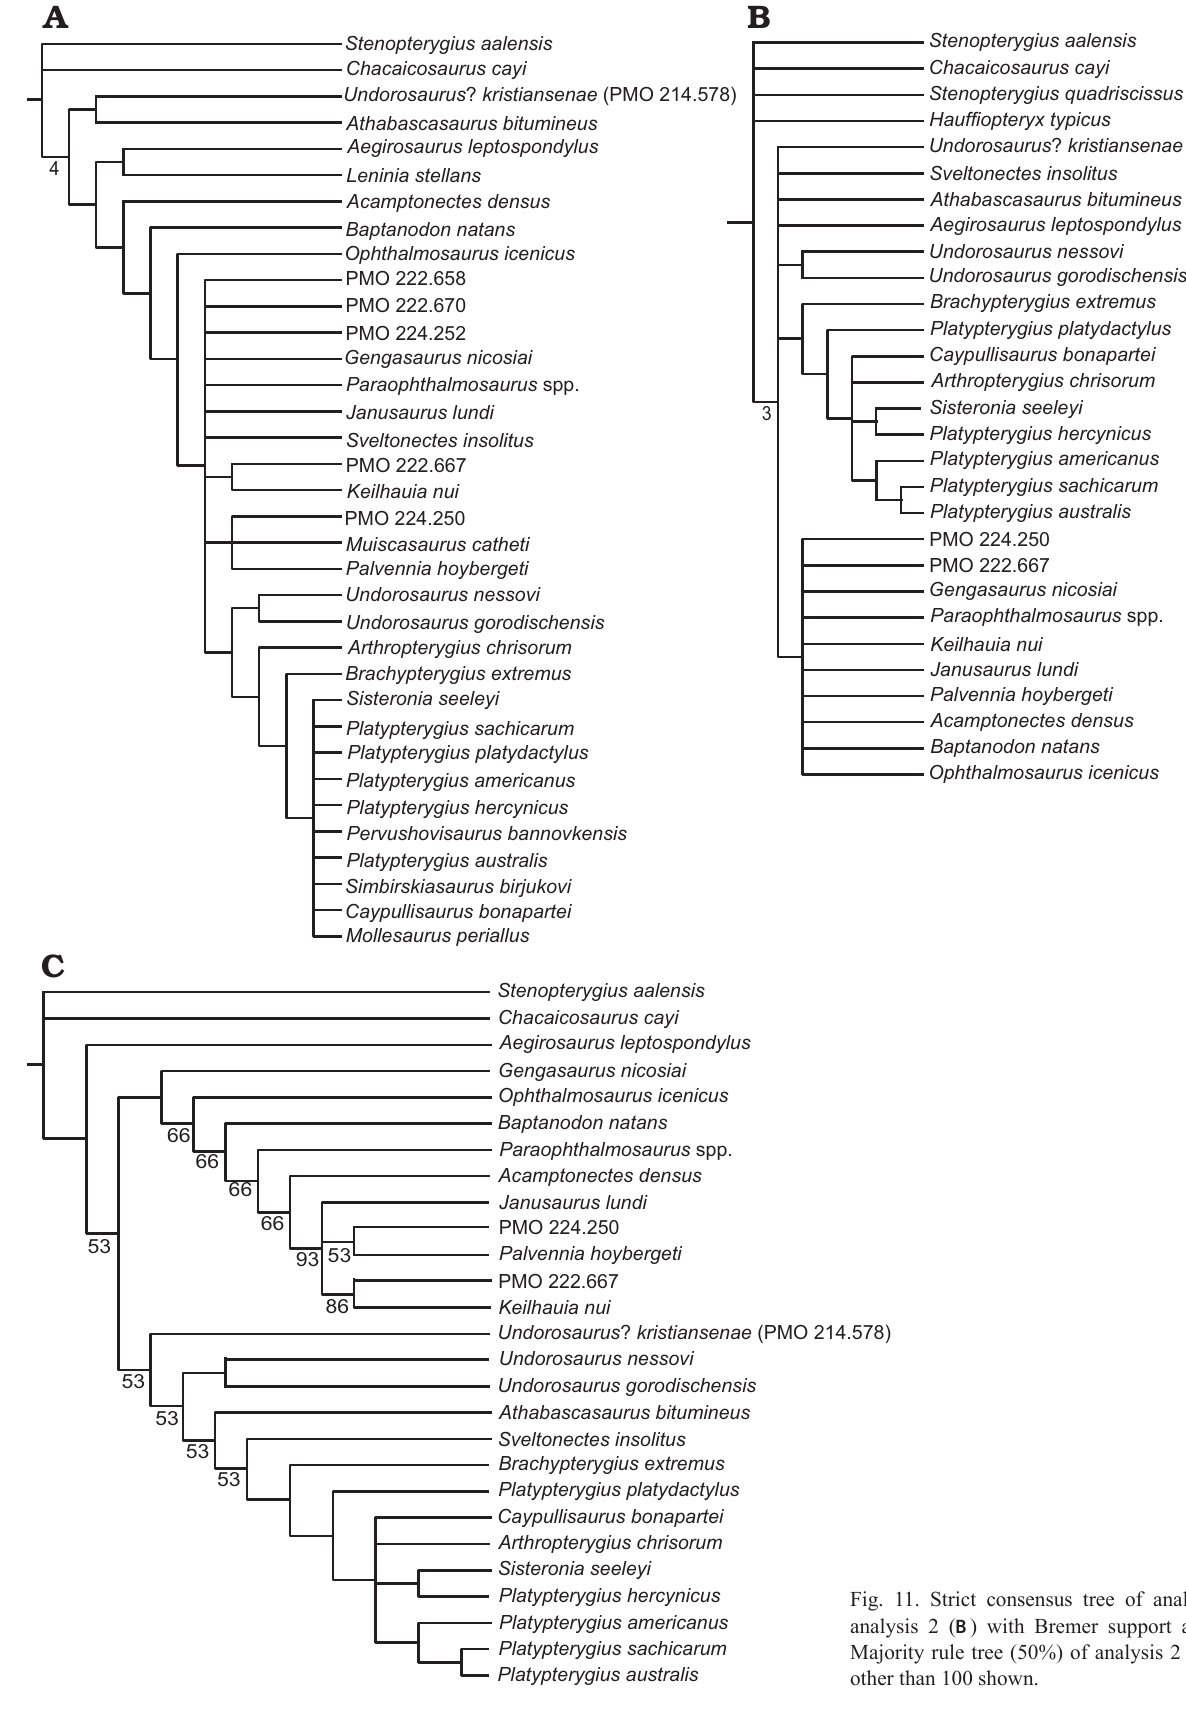
Fig. 11. Strict consensus tree of analysis 1 ( A ) and ana lysis 2 ( B ) with Bremer support above 1 shown. Majority rule tree (50%) of analysis 2 ( C ) with values other than 100